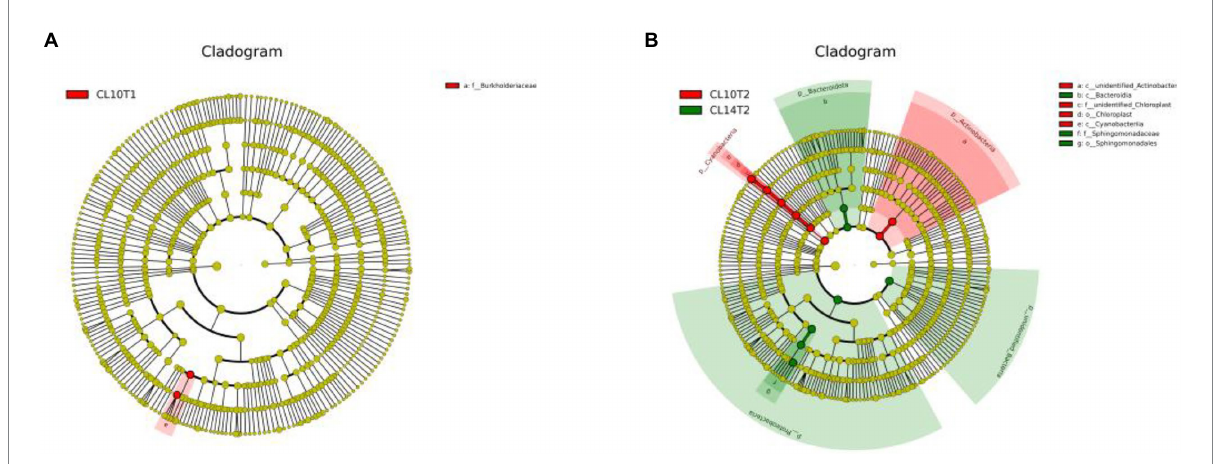
FIGURE 1 LDA Effect Size (LEfSe) analysis of soil bacteria communities of soybean cultivars under continuous cropping. (A) is the R1 growth stage, (B) is the R6 growth stage. CL10T1, at the R1 growth stage, L10 under CC treatment; CL10T2, at the R6 growth stage, L10 under CC treatment; CL14T2, at the R6 growth stage, L14 under CC treatment.